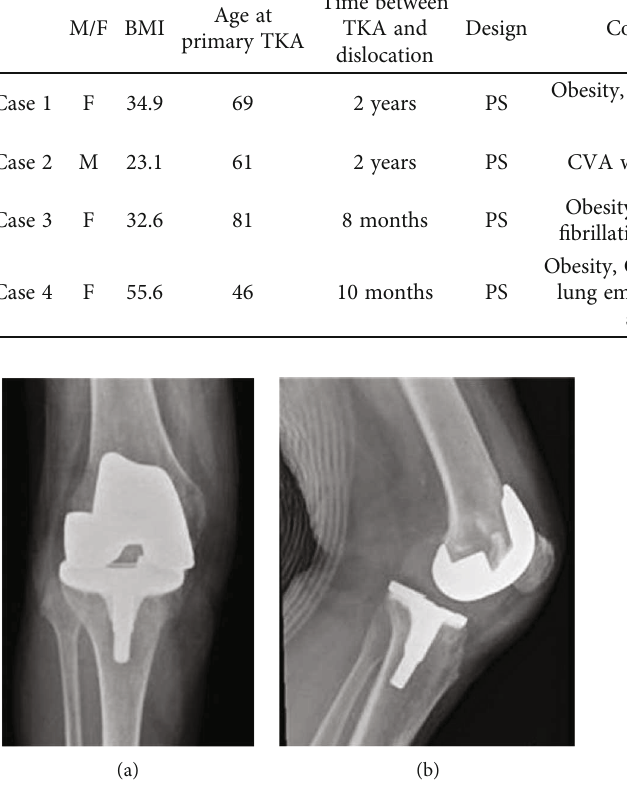
Figure 1: (a) Anteroposterior radiograph of the knee from case 1 at presentation in the emergency room. (b) Lateral radiograph of the knee from case 1 at presentation in the emergency room. Figure